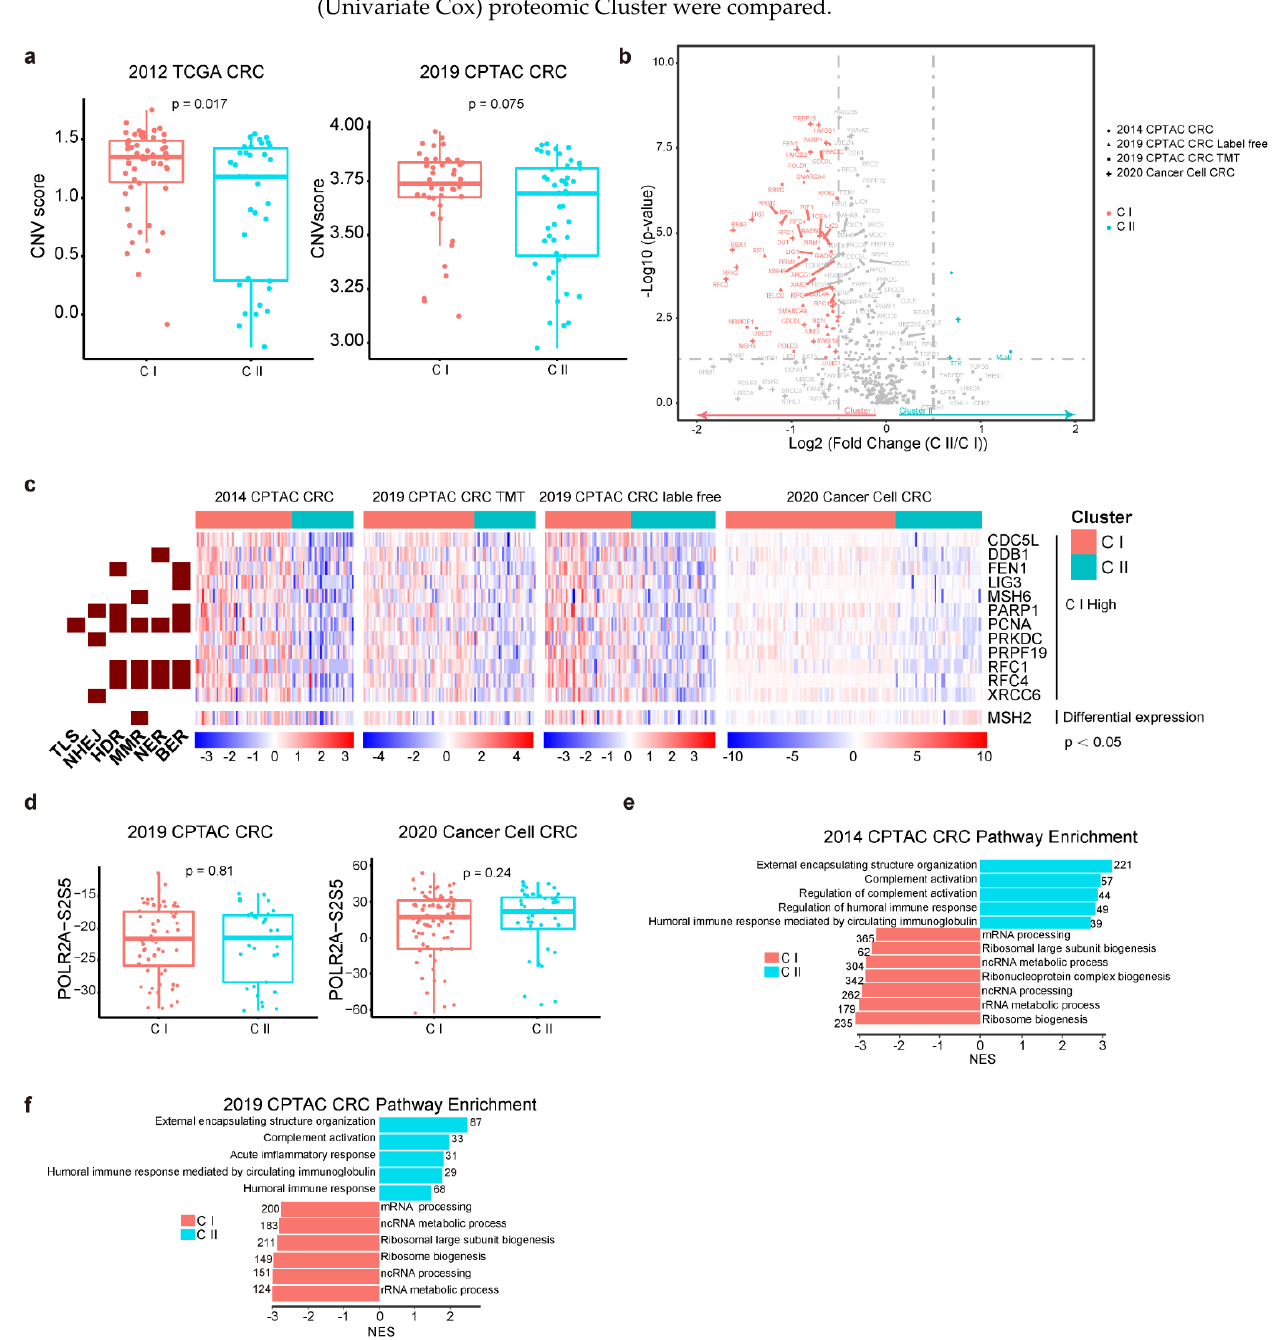
Figure 3. CI and CII possess different molecular characteristics. ( a ) Box plot showing CNV score in two clusters in 2012 TCGA CRC and 2019 CPTAC CRC databases. ( b ) Volcano plot showing expressions of DNA damage proteins in two clusters in three CRC proteomics databases (Blue and red indicate Log 2 (fold change (CII/CI) > 0.5 and Log 2 (fold change (CII/CI) < − 0.5 respectively, p < 0.05). ( c ) Heatmap showing selected DNA damage protein engaged DNA repair pathways ( p < 0.05) through four proteomic cohorts. ( d ) Box plot showing phosphorylation of Polymerase 2 (PORL2A) at S2/5 sites in two clusters in 2019 CPTAC CRC databases (left) and 2020 Cancer cell CRC databases (right) [23,24]. ( e , f ) Pathway enriched in two clusters in two CRC proteomics databases analyzed by GESA (Two − sided unpaired t test).